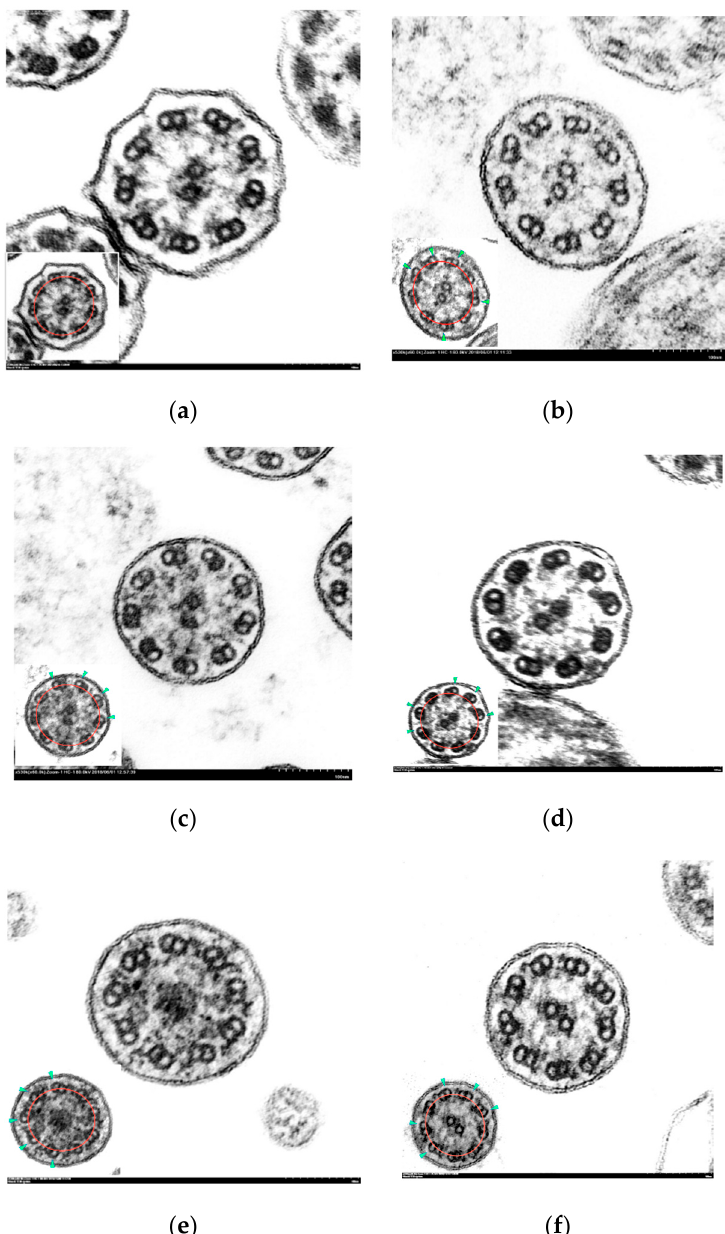
Figure 3. Electron micrographs of transverse sections of cilia with axonemal symmetry break. Inset: ciliary sections with marked axonemal circumference (red line) and tilted doublets (green arrowhead).( a ) Normal cilium showing conserved ultrastructure and axonemal symmetry; ( b – f ) ciliary axonemes with more than 3 tilted peripheral doublets: ( b ) partial absence of outer dynein arms (short arms); ( c ) absence of inner and outer dynein arms; ( d ) complete absence of outer dynein arms; ( e ) central complex defect: absence of central pair; ( f ) ciliary axoneme with normal ultrastructure and axonemal asymmetry. (Micrographs, original magnification ×